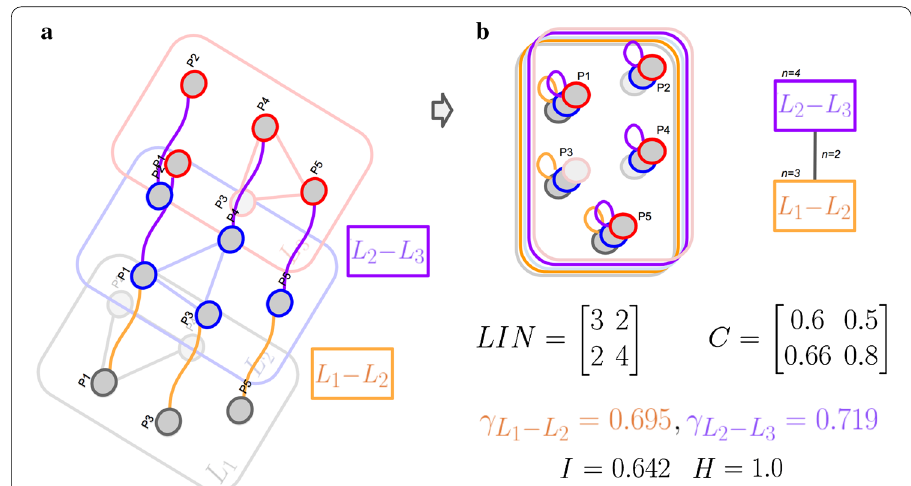
Fig. 3 Computing entanglement on the transition coupling edges. a Coupling edges are illustrated in orange ( L 1 − L 2 edges) and in purple ( L 2 − L 3 edges). b Computing the corresponding LIN and entanglement measures. Coupling edges of a same node resemble loops except they are defined across two layers. We may notice that: the transition coupling L 2 − L 3 shows a slightly higher index since there are more transitions for this coupling; the homogeneity H is (almost) maximal since both layers are (almost) equally intertwined (only 2 layers, actual H ≈ 0.99986 )